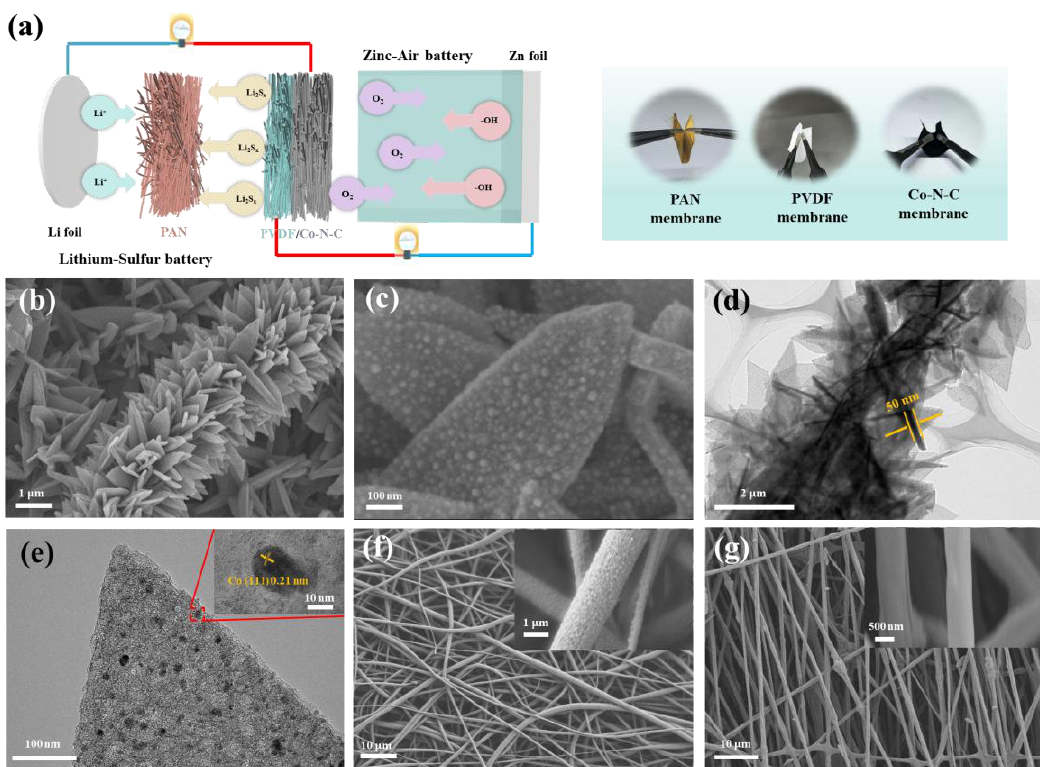
Figure 1. ( a ) Gradient flexible a lithium–sulfur battery and zinc–air battery system. Morphology characterization of Co−N−C nanosheets. ( b , c ) SEM images of Co−N−C. ( d , e ) TEM images of Co−N−C, inset: HRTEM image in the marked zone; SEM images of ( f ) PVDF fibers. ( g ) PAN fibers.